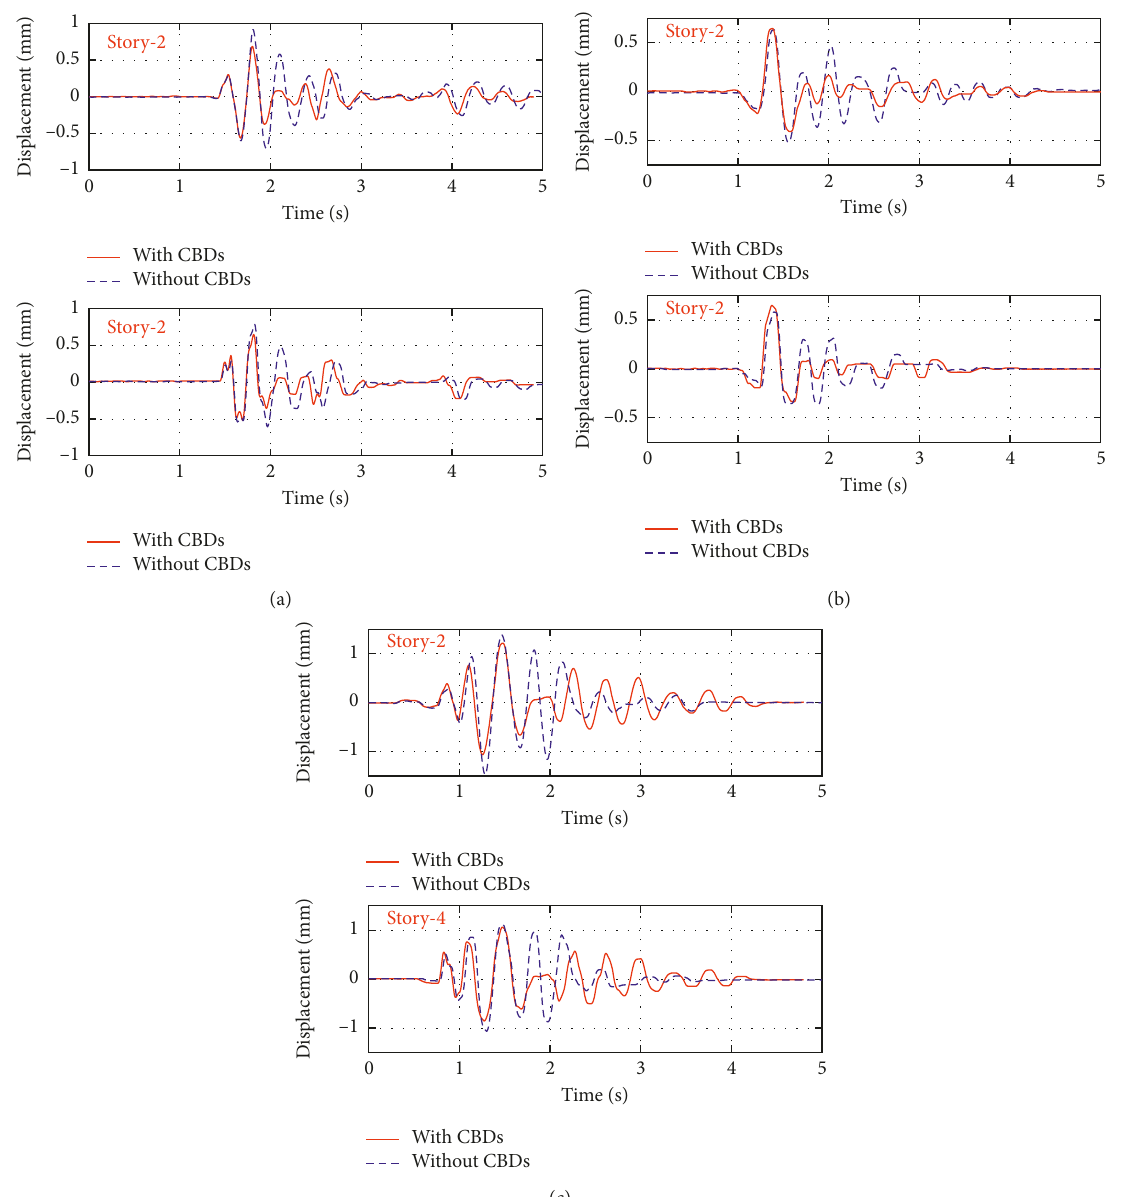
Figure 13: Time-history comparison of interstory displacements under frequent-intensity earthquakes: (a) El Centro, (b) Impvall, and (c)